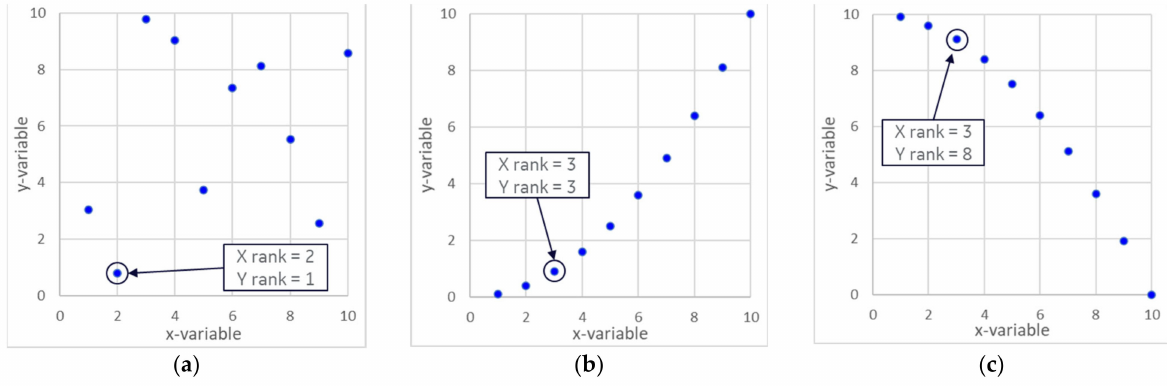
Figure 14. Correlation coefficient interpretation: ( a ) No correlation ρ = 0; ( b ) Strong positive correla- tion ρ = + 1; ( c ) Strong negative correlation ρ = −